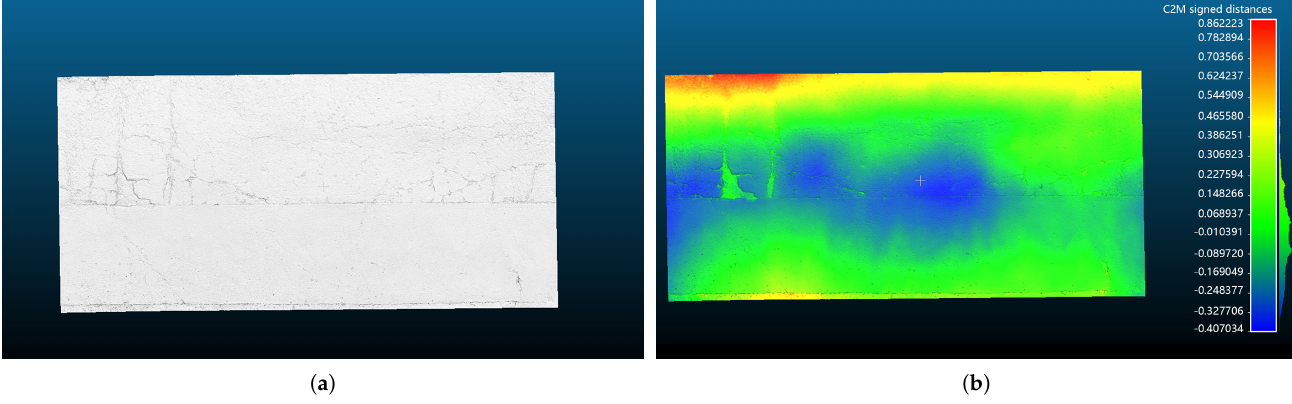
Figure 15. Top view and the heatmap of the reconstructed pavement. ( a ) Top view; ( b ) heatmap. We measured the lid diameter for the reconstructed and real scenes, calculated the factor, and then scaled the model by this factor. Then we measured the largest diameter of the scaled and actual teapots to judge the precision. The largest diameter of the scaled model was about 0.1993 m, which was quite close to the actual diameter of the teapot (0.20 m). In this experiment, the focal length of the camera was 2615.6018 pixels. The distance between the camera and the teapot was less than 1 m. The spatial resolution was about 0.00038 m, which ensured the high-resolution